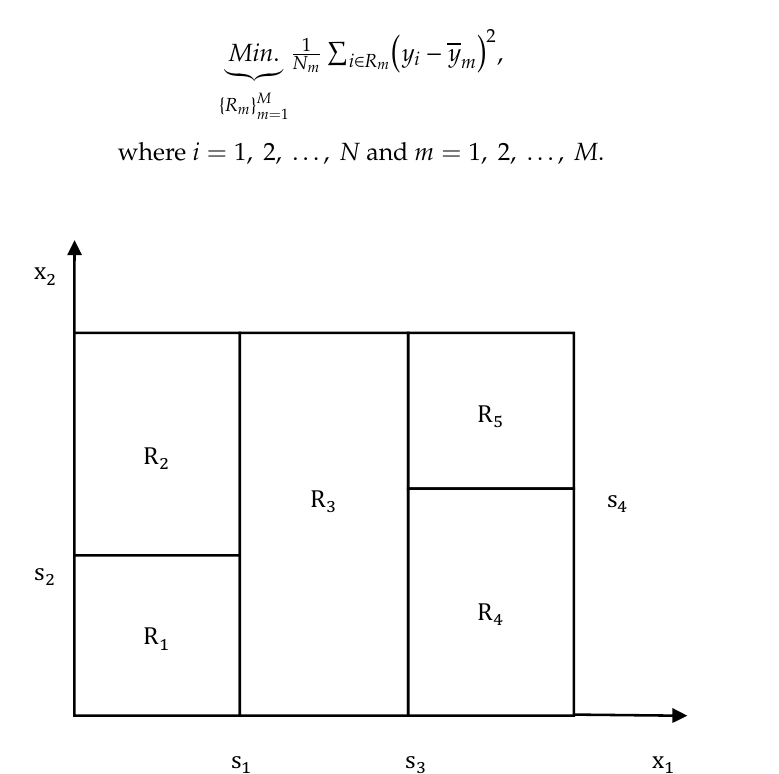
Figure 4. Graphical representation of recursive binary splitting.